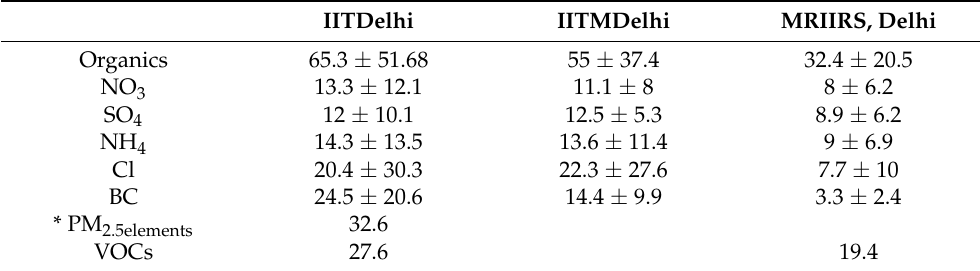
Table 2. The sampling period mean concentrations of organics, nitrate, sulfate, ammonium, chloride, BC, elemental PM 2.5 , and VOCs (values are in µ gm − 3 ± standard deviation, except for VOCs, which arein ppbv) as reported by Lalchandani et al. and Rai et al. [10,12]. IITDelhi IITMDelhi MRIIRS, Delhi Organics 65.3 ±